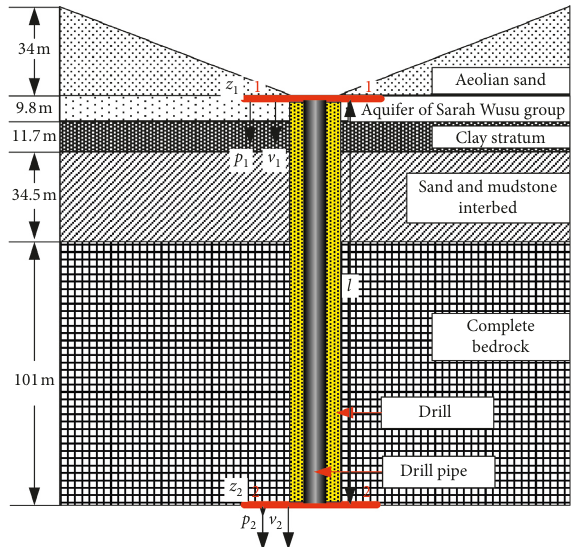
Figure 9: Computing model for sediment-water flow.